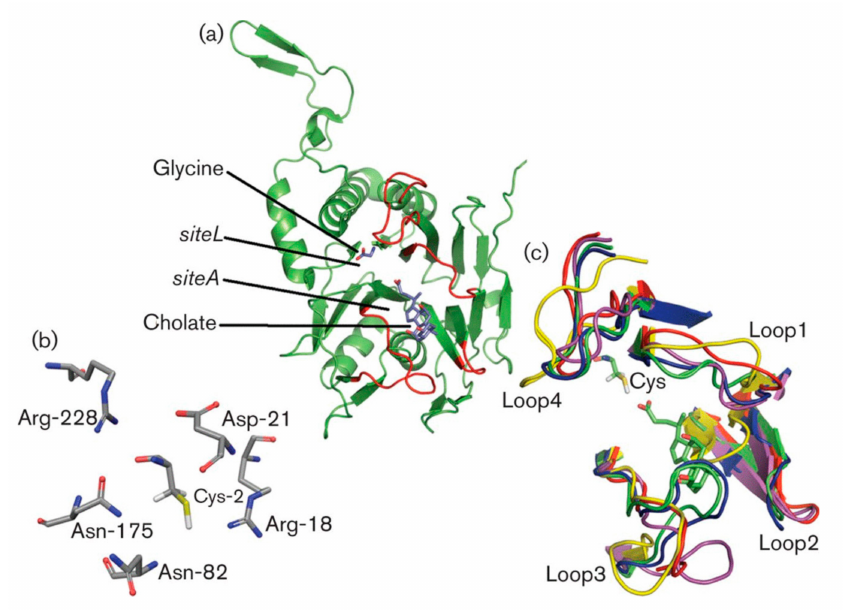
Figure 4. ( a ) The 3D structure of Clostridium perfringens Cp BSH following the hydrolysis of glycocholic acid (GCA) with the products glycine bound in the active site (siteL) and cholate bound in the binding site (siteA) (both products are shown in stick representation and labelled). ( b ) The geometrical arrangement of the six major catalytic residues in the active site of Cp BSH. ( c ) The superimposition of the four loops of the substrate binding site (loop1-loop4) from Bifidobacterium longum Bl BSH (red), Cp BSH (magenta), Bacteroides thetaiotaomicron Bt BSH (yellow), Lyinibacillus sphaericus Bsp PVA (blue) and Bacillus subtilis Bsu PVA (green). The active site nucleophilic residue Cys is shown and labelled. From